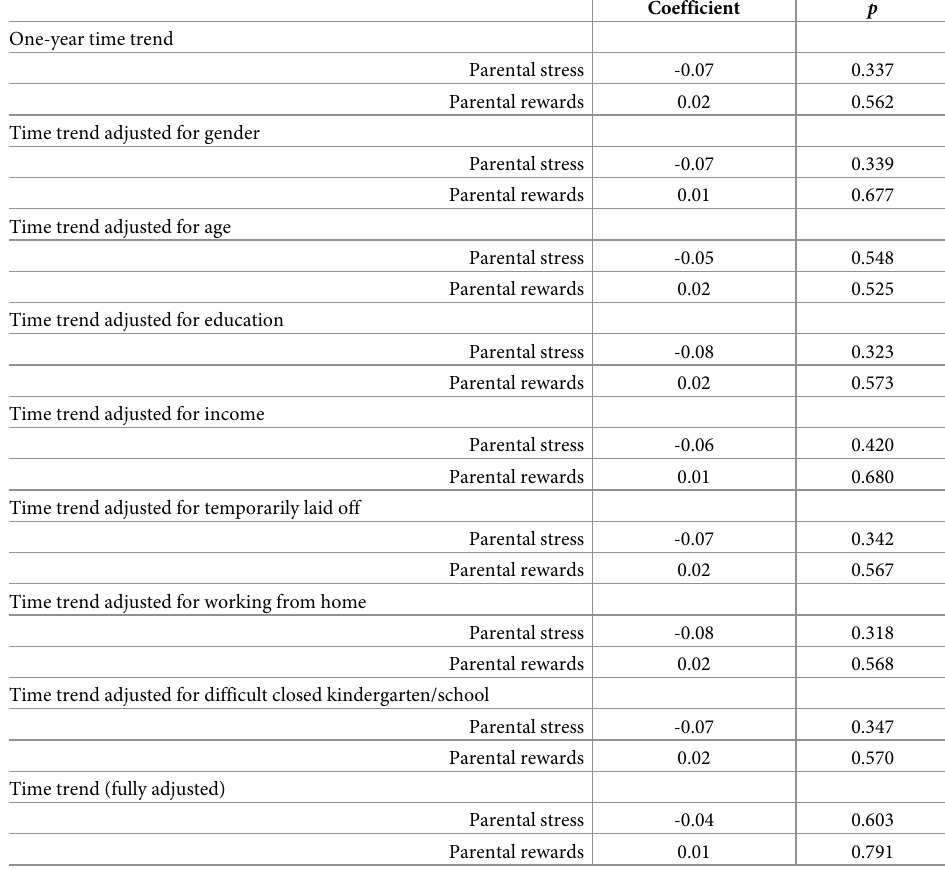
Table 2. Change in the levels of parental stressors or rewards between time point 1 and time point